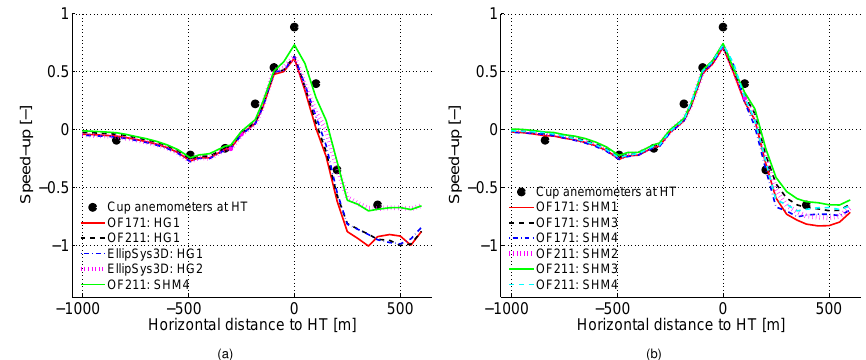
Figure 4. Askervein Hill: speedup along the line A.